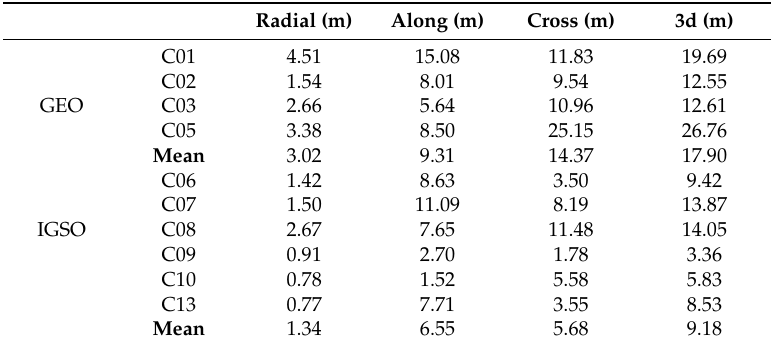
Table 4. Root mean square (RMS) errors of the first hour of healthy broadcast ephemerides after maneuvering in 2017 for each Beidou satellite.